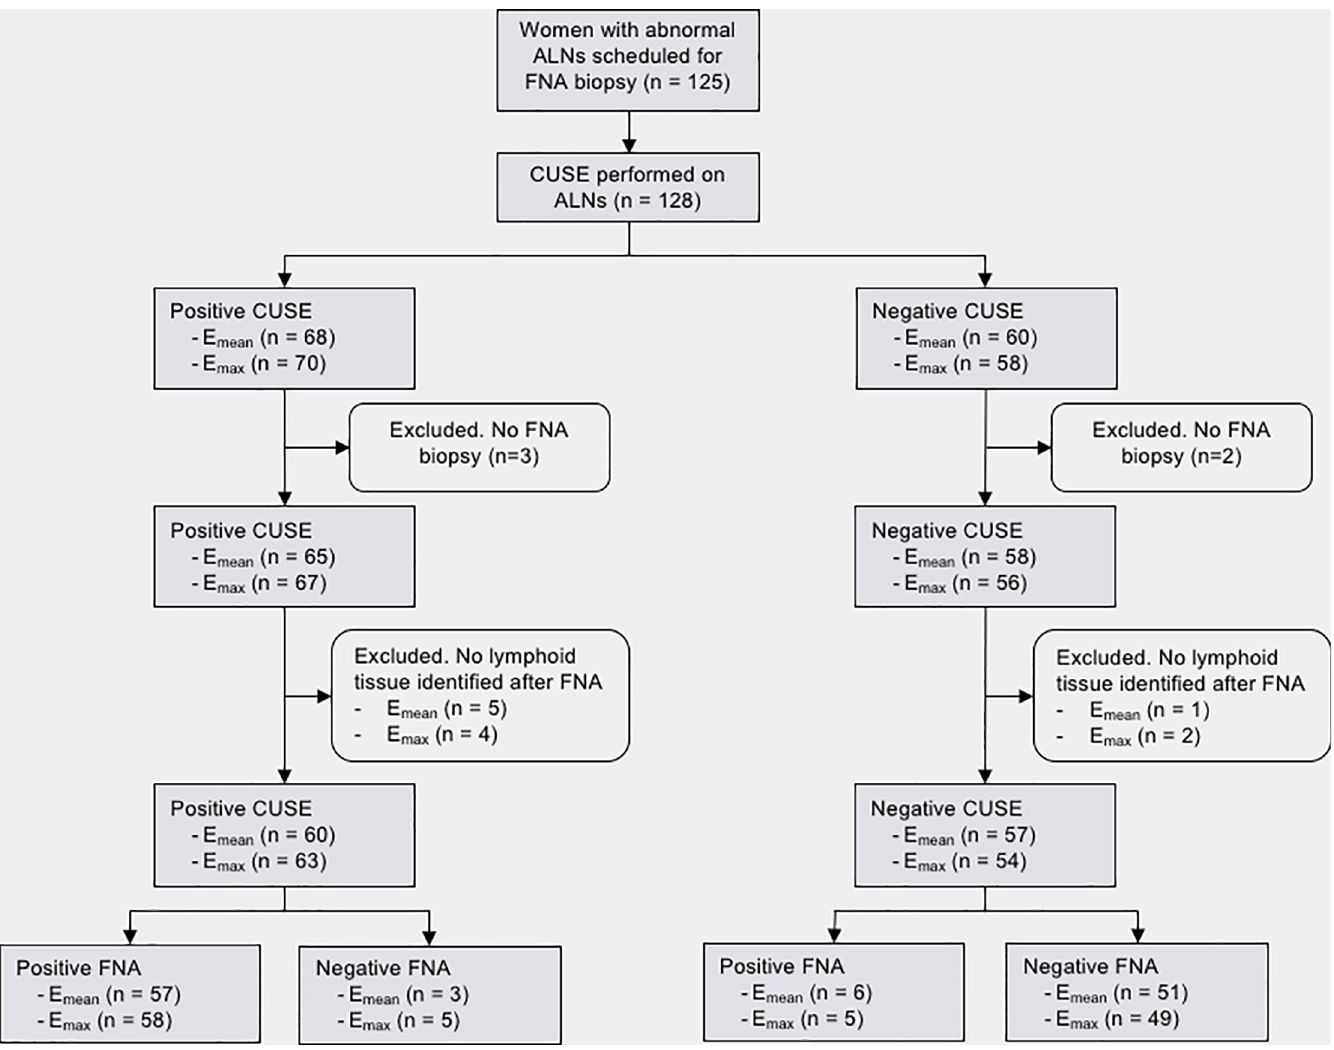
Fig 2. Flowchart of the study population showing CUSE and FNA biopsy